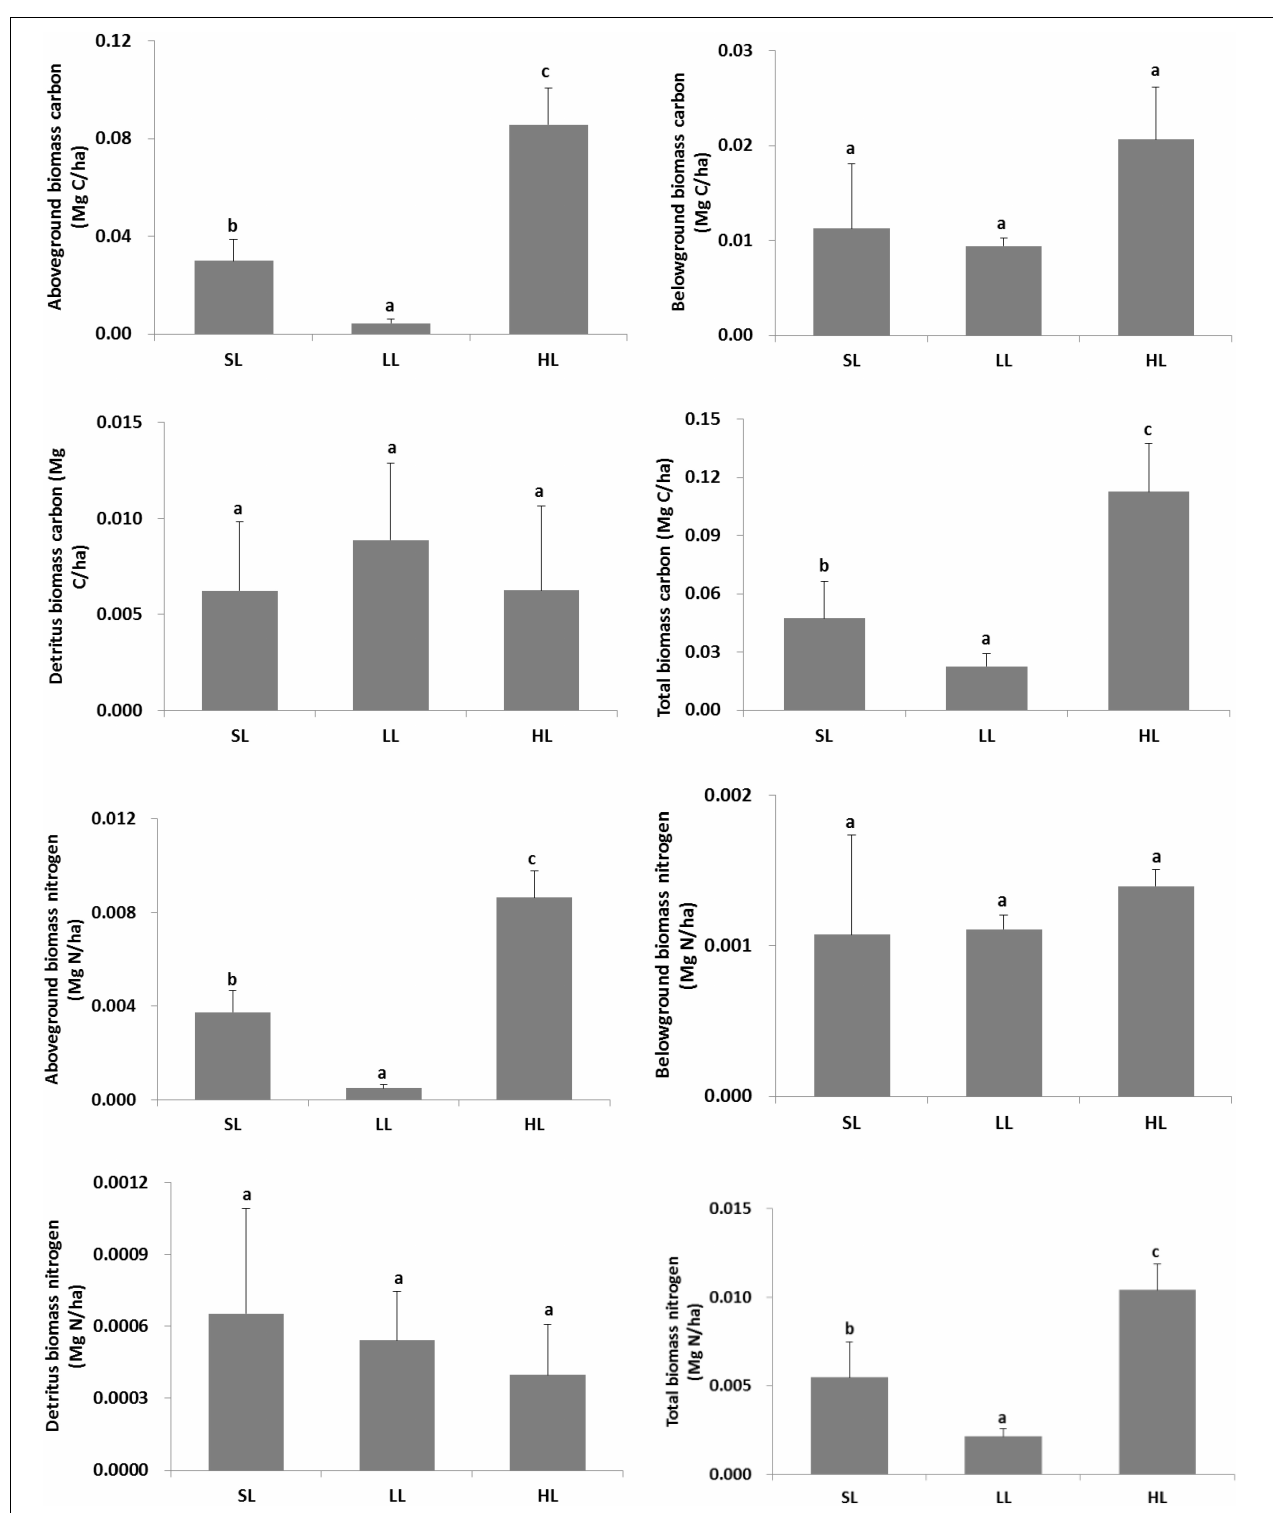
FIGURE 7 | Response of vegetative carbon and nitrogen stock to light treatments. Total biomass included living above-ground and below-ground tissues, and detritus above the surface sediment. Saturating light: SL, 200 µ mol photons/m 2 /s; low light: LL, 20 µ mol photons/m 2 /s; high light: HL, 600 µ mol photons/m 2 /s. SL and HL were in the optimal light range between the minimum saturating light and the minimum inhibiting light. Different letters on the bars indicate mean values for a particular light condition that significantly differed at ( p < 0.05) (Mean ± SD, n = 3) analyzed by one-way ANOVA.